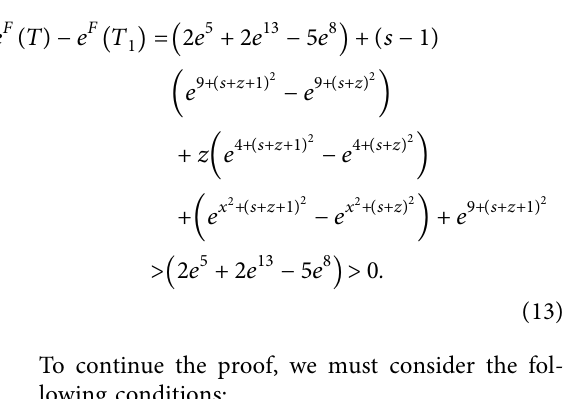
Figure 11: The tree T